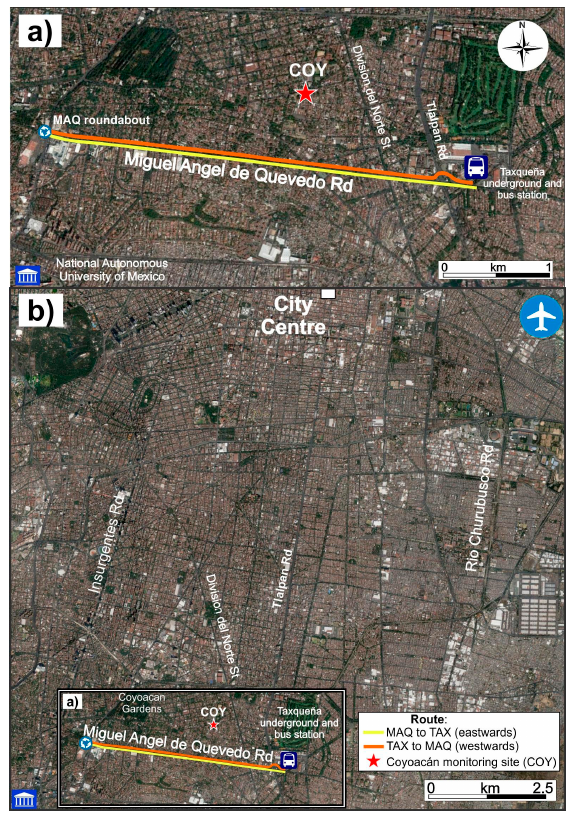
Figure 1. ( a ) The Miguel Angel de Quevedo (MAQ) Rd and the Coyoacán (COY) monitoring site close to MAQ Rd in the local context; ( b ) The MAQ Rd in relation to the whole Mexico City Metropolitan Area (MCMA). Table 1. Transport modes and distances travelled. (MAQ: Miguel Angel de Quevedo; TAX: Taxqueña; CC: conventional car; HEC: hybrid-electric car).